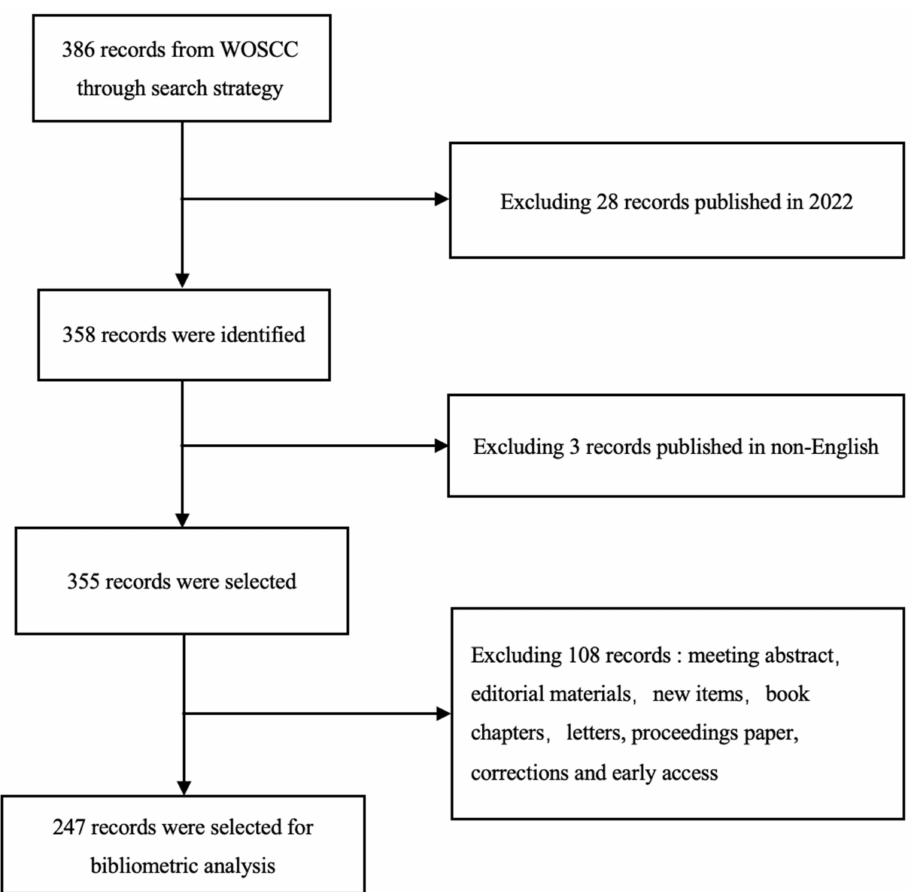
Figure 1. Flow chart of the article